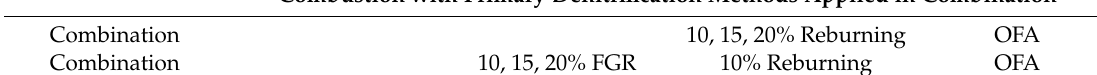
Table 4. Primary methods applied individually and in combination. Legend: FGR—flue-gas recirculation. Ratio Combustion without / with Primary Denitrification Method Applied Individually Without 10, 15, 20% FGR 10, 15, 20, 25% Reburning Combustion with Primary Denitrification Methods Applied in Combination Combination 10, 15, 20% Reburning OFA Combination 10, 15, 20% FGR 10% Reburning OFA